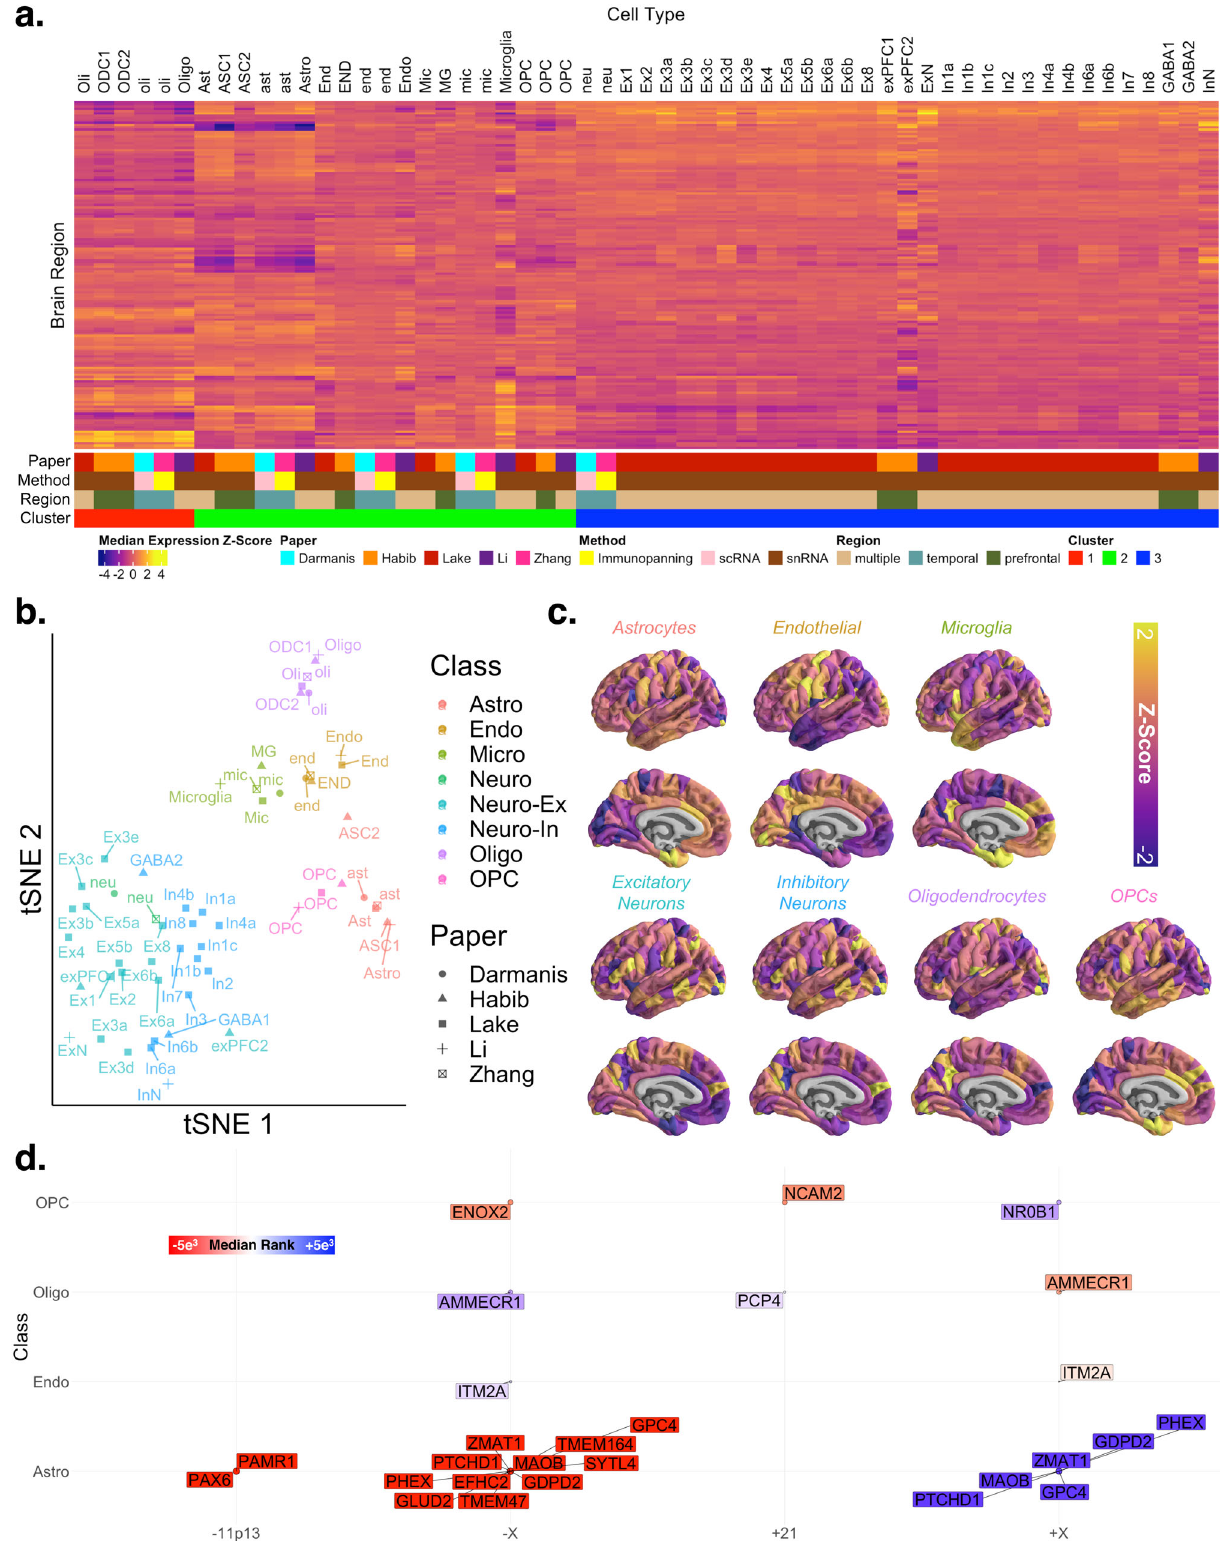
The correct version of Fig. 2